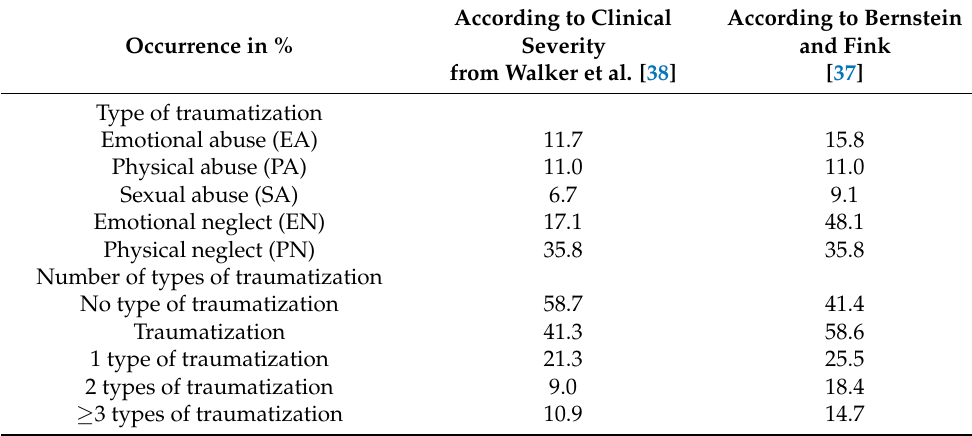
Table 5. The prevalence of traumatization according to the CTQ.